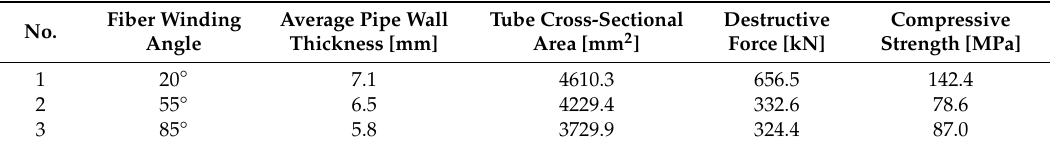
Figure 3. Pipe rims for wall thickness measurements.